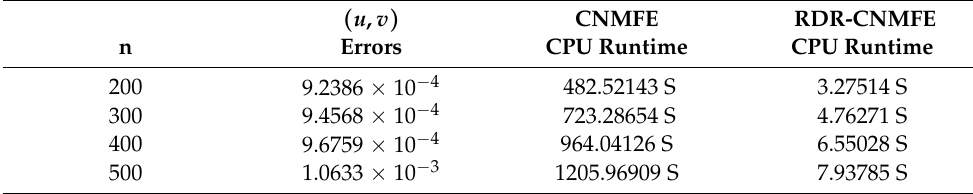
Table 1. Errors between the CNMFE and RDR-CNMFE solutions and CPU runtime. ( u , v ) CNMFE RDR-CNMFE n Errors CPU Runtime CPU Runtime